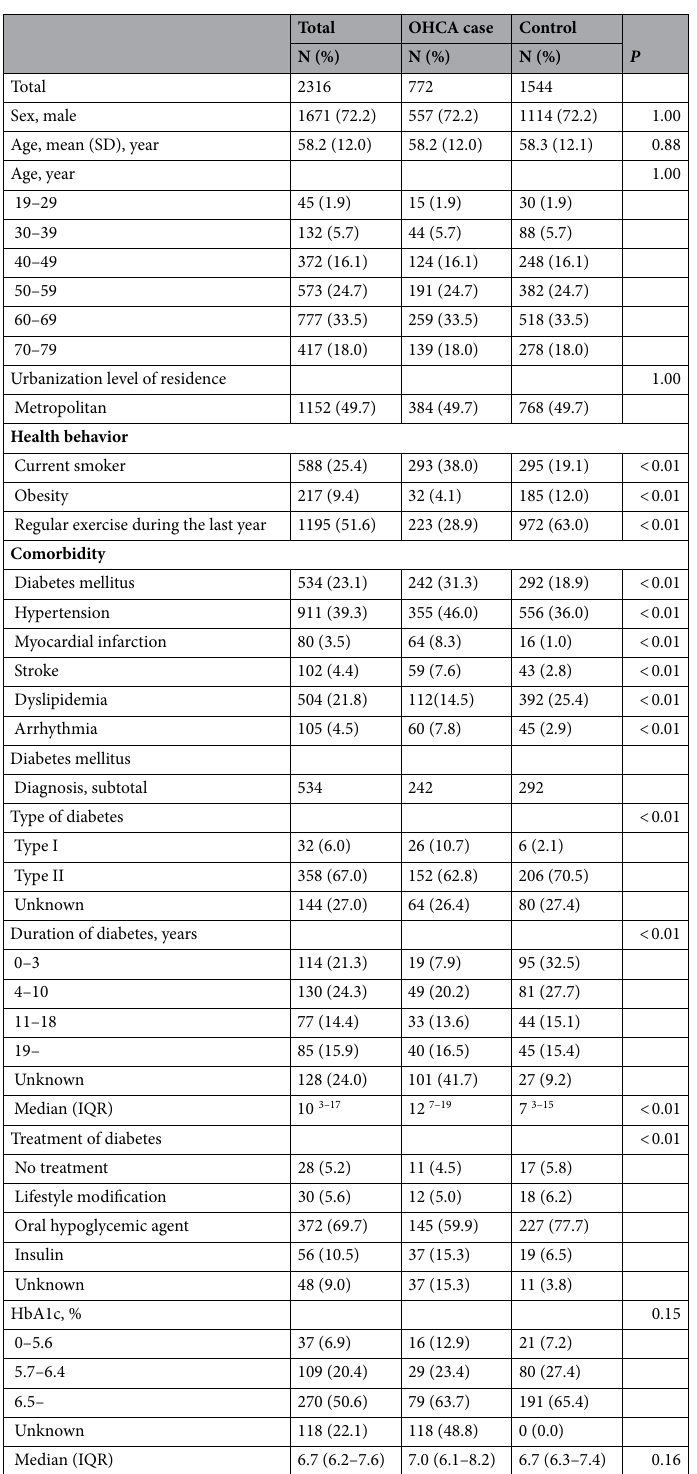
Table 1. Characteristics of the out-of-hospital cardiac arrest case group and age-, sex-, and urbanization level- matched control group. IQR, interquartile